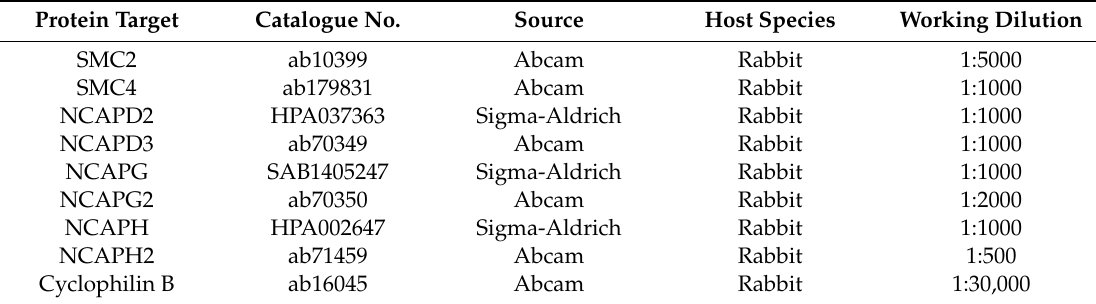
Table 1. List of antibodies employed in Western blot